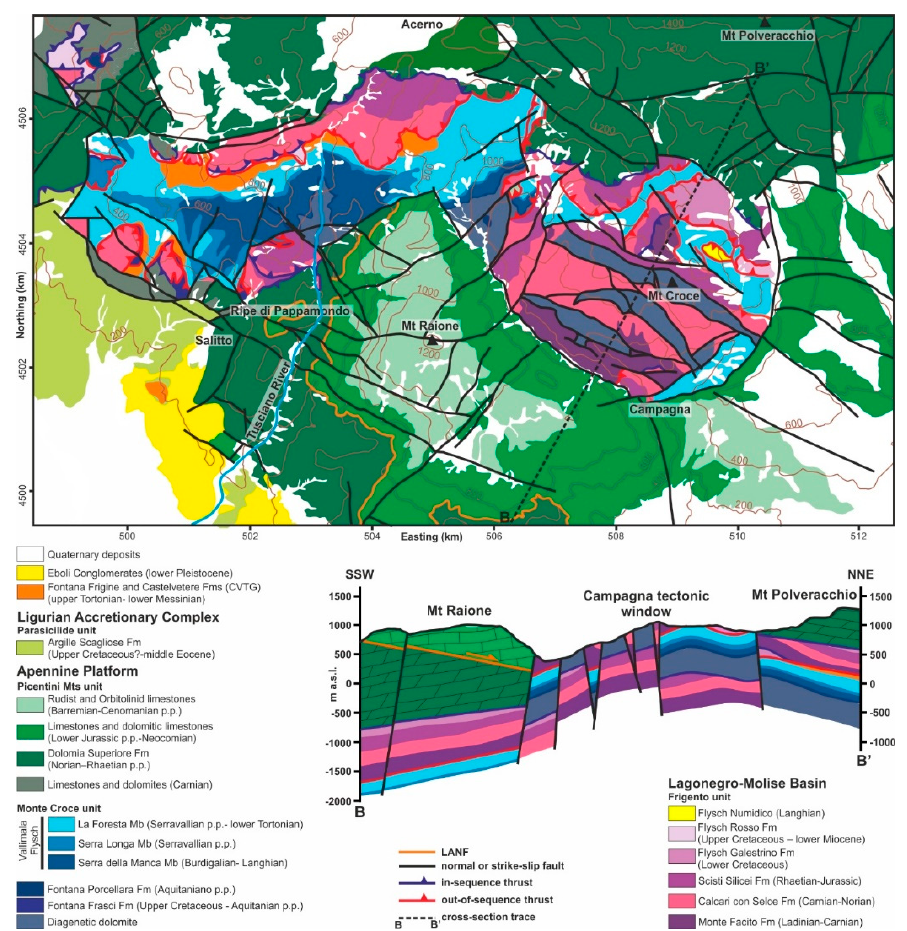
Figure 3. Geological map of the Campagna tectonic window (modified after [23,24]). WGS84-F33N Projection.